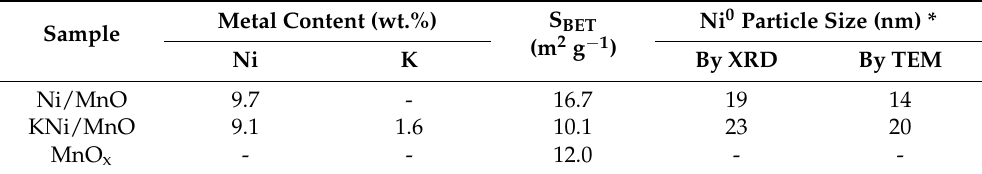
Table 1. Physical and chemical properties of the MnO x support and nickel-based catalysts. Metal Content Sample